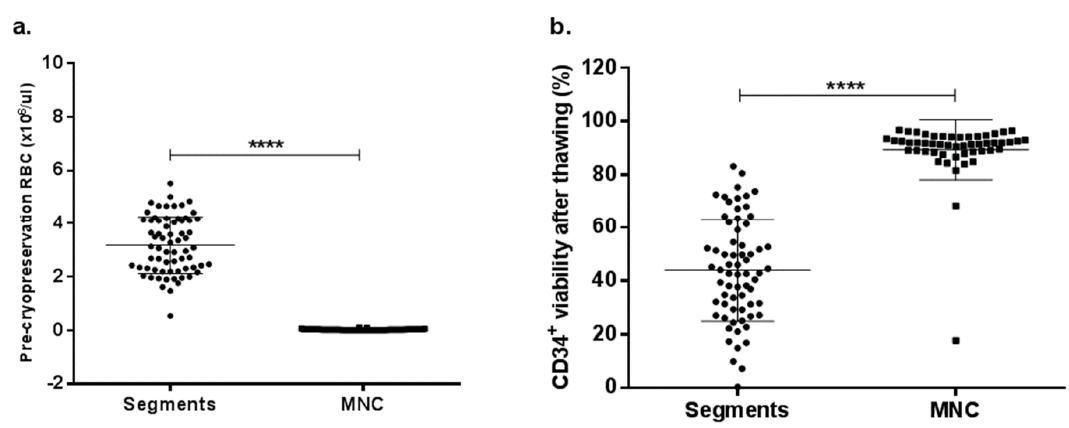
Figure 5. RBC content and CD34 + cell viability after thawing comparison between UCB unit segments and RBC-depleted mononuclear cells (MNC). ( a ) Pre-cryopreservation RBC difference between two volume reduction methods: UCB traditional processing and density-gradient MNC isolation. ( b ) CD34 + cell viability after thawing differences between two volume reduction methods: UCB traditional processing and density-gradient MNC isolation .